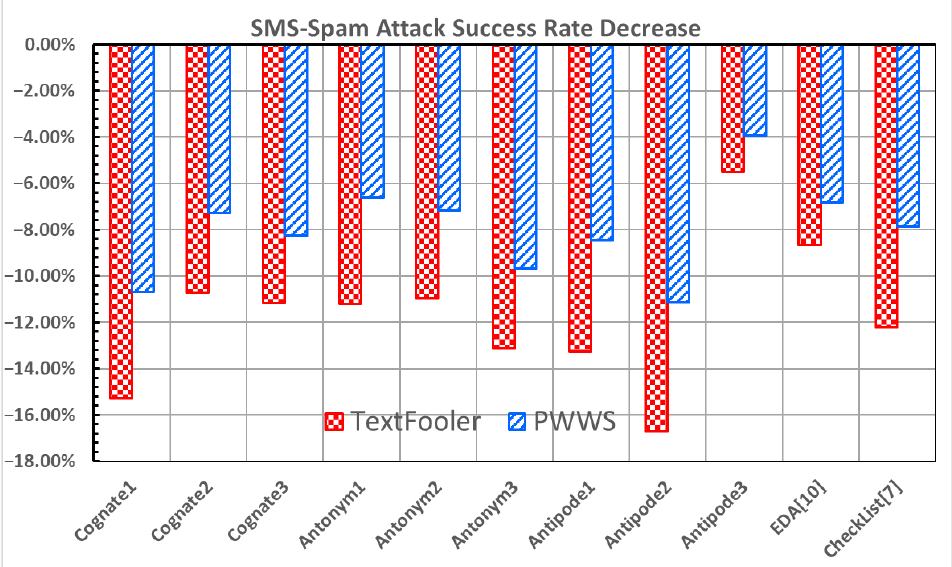
Figure 12. SMS-Spam Attack Success Rate Decrease.